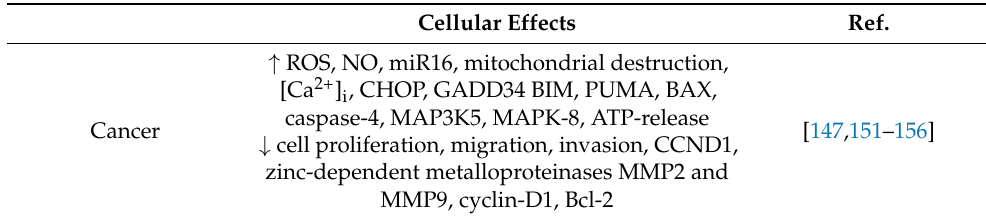
Table 3. Physiological effects of SeNP in